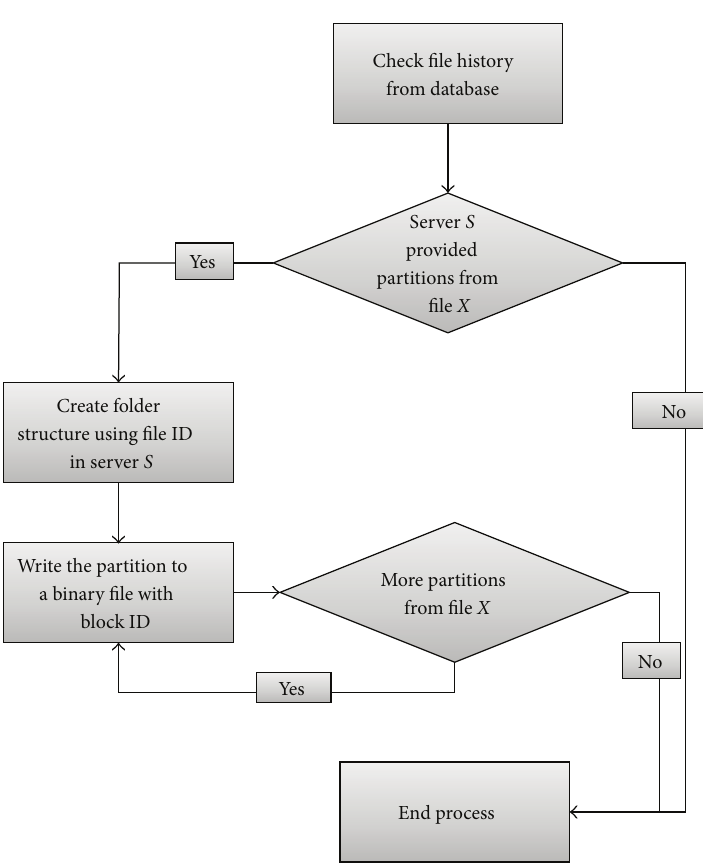
Figure 6: Cloud file redundant data removal